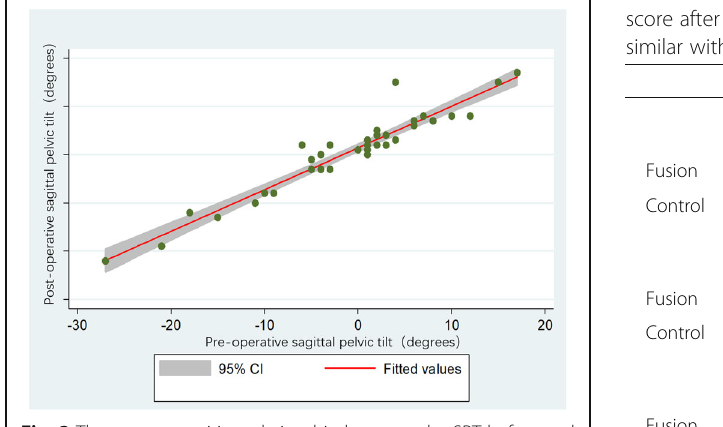
Fig. 3 There was a positive relationship between the SPT before and after THA